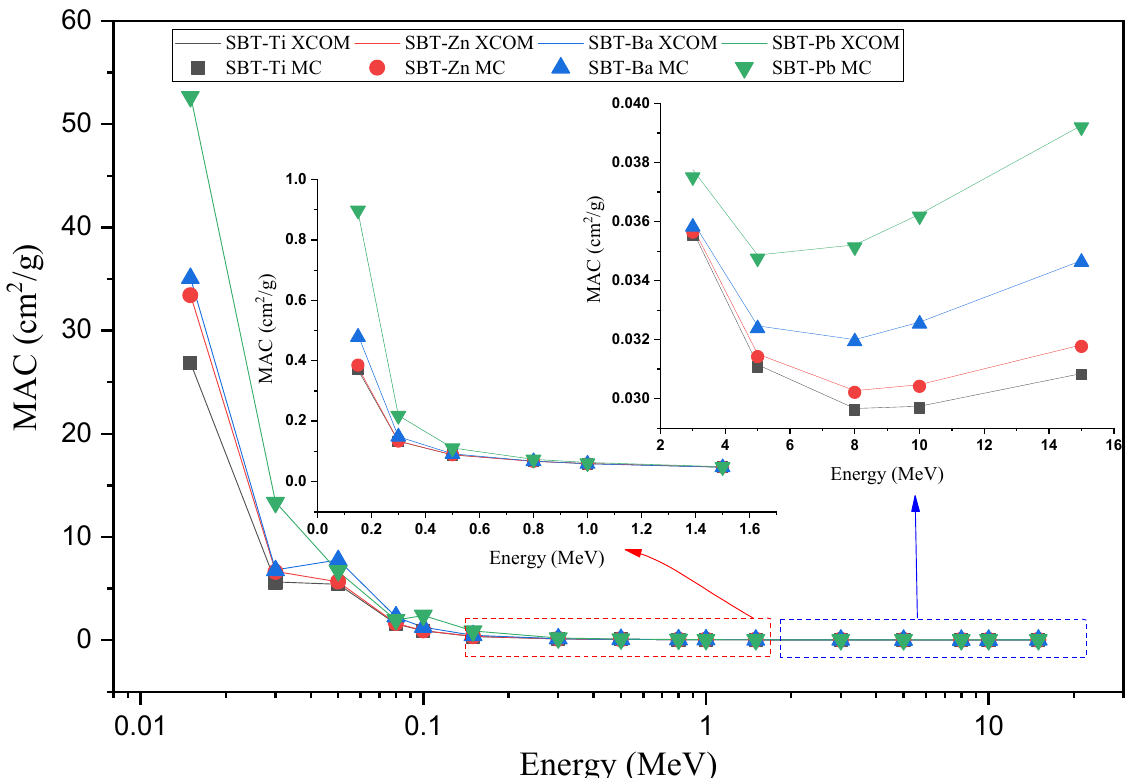
Figure 6. Variation of the mass attenuation coefficient versus the gamma-ray energy at different interaction regions. The relation between the half-value layer (HVL, cm) (the thickness required to reduce the incident gamma flux to half of its initial value [37]) and the incident gamma-ray photons was illustrated in Figure 7. The thinner HVL achieved at the lowest gamma-ray energy among the studied energy range (i.e., 0.015 MeV) takes values 0.006, 0.005, 0.004, and 0.002 for samples SBT-Ti, SBT-Zn, SBT-Ba, and SBT-Pb, respectively. This law value is due to the predominant of the PE interaction at the mentioned energy. Thus, the photon energy is absorbed in one collision with a boundary electron. Also, it is clear that the SBT-Pb has a thinner HVL compared to other fabricated glass samples. This is related to the PbO compound, which has a high density and cross-section of interaction. Hence, insertion of the PbO offers an additional resistance for passing photons, and the result is a significant reduction in the HVL values. In the low energy region in which the PE interaction is predominant, the HVL suffers a high increase with raising the photon energy. Increasing the energy of incident photons higher than 0.1 MeV causes a change in the interaction mode in which gamma-ray interacts with the glass atoms, where the PE decreases and CS begins to increase with raising the incident gamma photon energies. In this energy interval, the HVL increased linearly with energy. The HVL varies the range of 0.191–3.588, 0.171–3.397, 0.114–3.117, 0.054–2.717 cm with average HVL of 1.844, 1.739, 1.546, and 1.234 cm for glass samples SBT-Ti, SBT-Zn, SBT-Ba, SBT-Pb, respectively. The HVL continued its